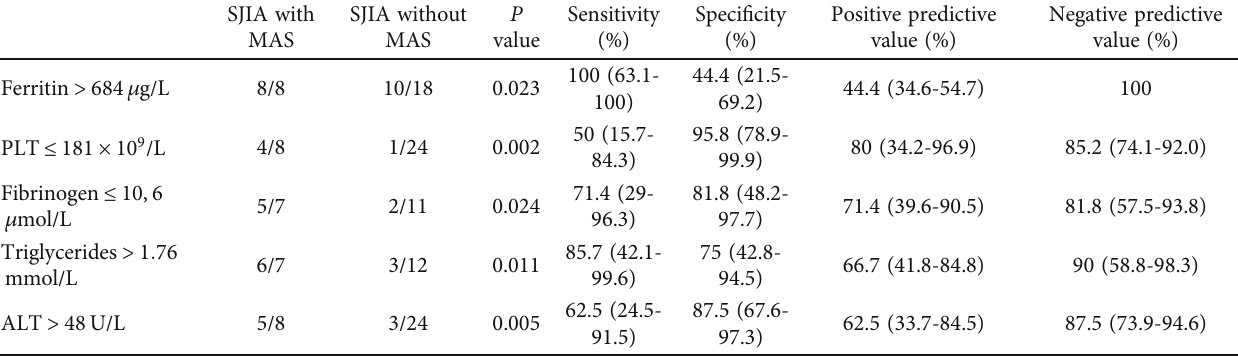
Table 6: Sensitivity and speci fi city of components of 2016 MAS classi fi cation criteria.